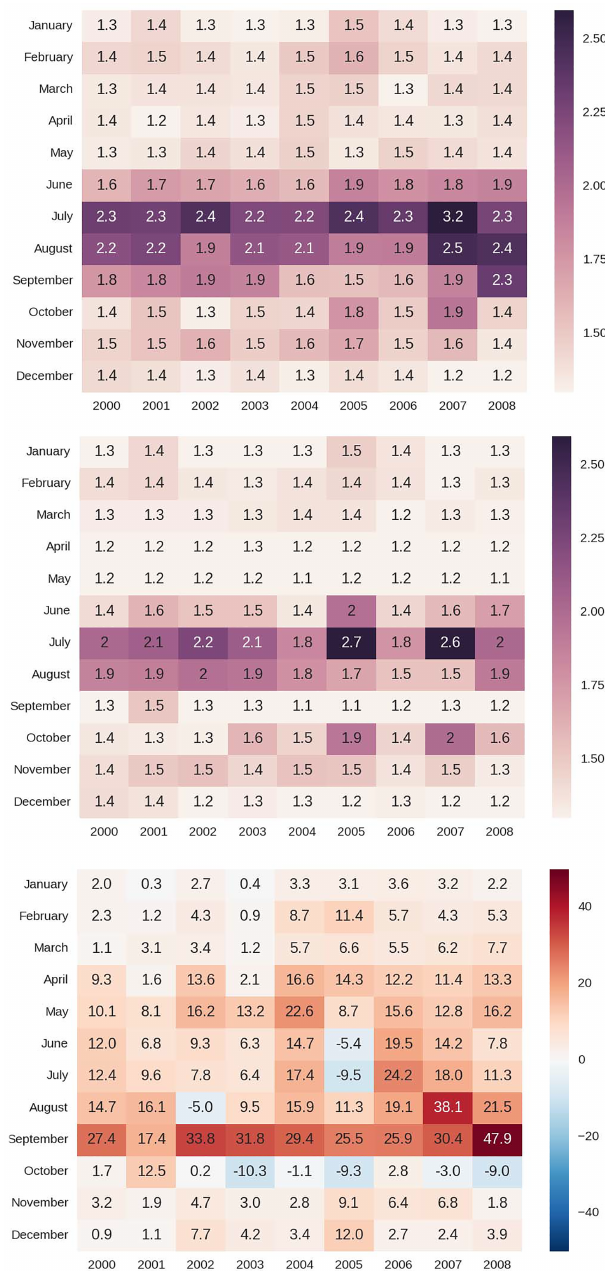
Figure 7. Same as Fig. 6, but for the sea ice